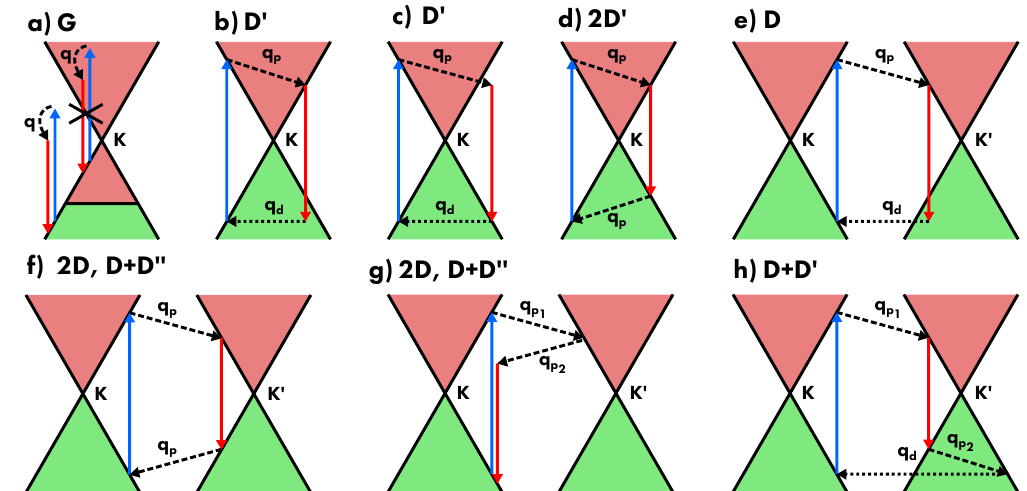
Figure 16. Raman scattering processes in graphene which determine the ( a ) G band, ( b , c ) D’ band, ( d ) 2D’ band, ( e ) D band, ( f , g ) 2D and D + D” bands, and ( h ) D + D’ band. The light induced electron-hole pair generation and the following recombination are indicated by blue and red arrows, respectively, whereas the phonon ( q p ) and the defect ( q d ) scattering are indicated by dashed and dotted arrows, respectively. Adapted with permission from Ref. [58]. Copyright (2013) Springer